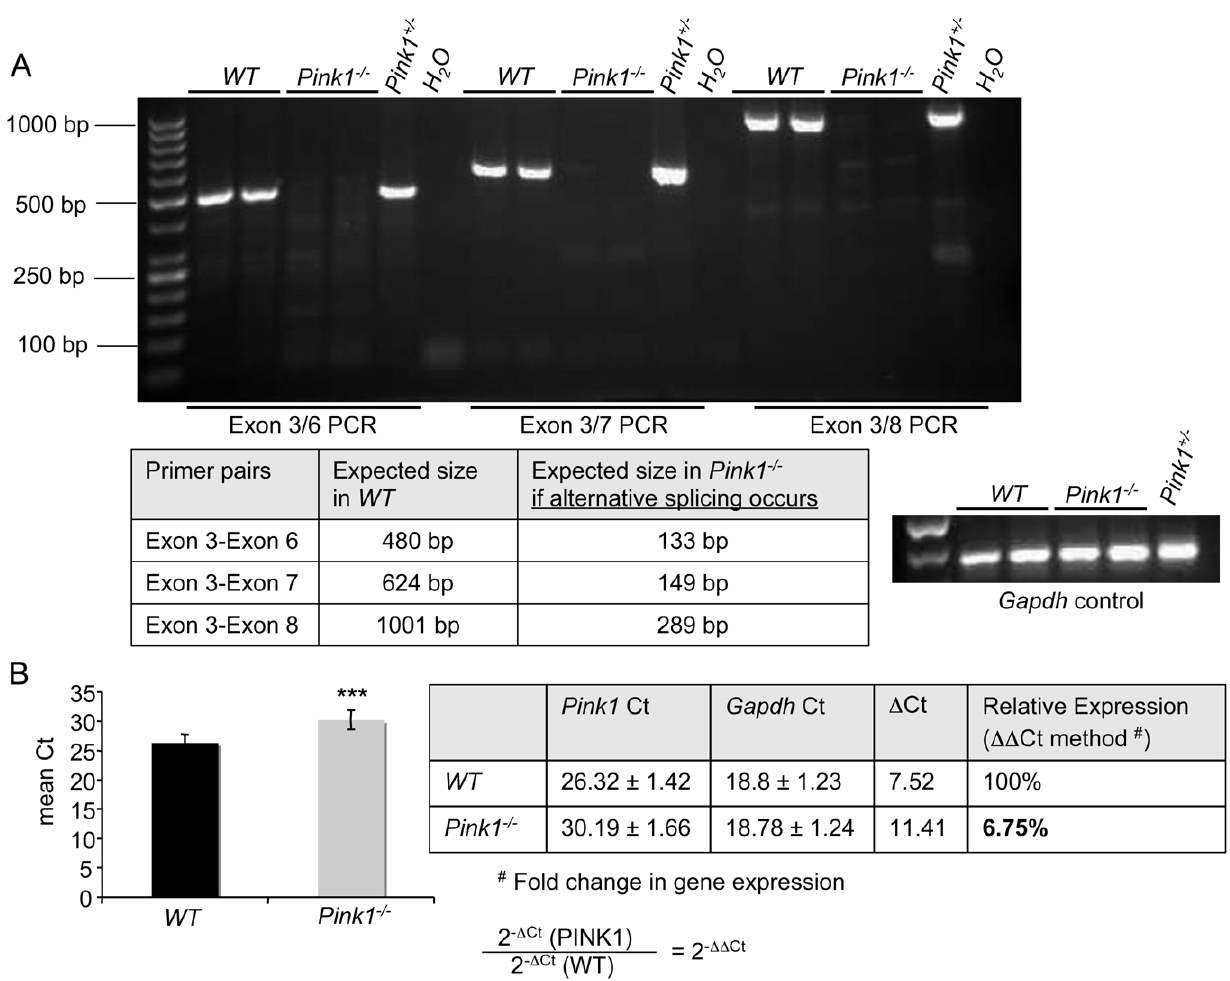
Figure 3. Analysis and quantification of Pink1 mRNA expression. Total RNA isolated from the brain of mice was converted to cDNA. (A) PCR with a forward primer located in exon 3 and reverse primers located in exon 6, 7 or 8, generating expected PCR products of 480, 624 and 1001 bp for the Pink1 wildtype allele in wildtype and Pink1 + / 2 samples. In contrast, PCR products of 133, 149 and 289 that would arise if exon 3 were directly spliced to exon 6, 7, or 8 in transcripts derived from the mutant Pink1 allele were absent in both Pink1 + / 2 and Pink1 2 / 2 samples. This shows that alternatively spliced transcripts are not generated from the disrupted Pink1 allele. (B) Quantitative real-time PCR with primers located in exon 1 (forward) and exon 3 (reverse) showing that Pink1 2 / 2 mice express at most 6.8% of a truncated Pink1 mRNA encompassing exons 1–3, compared to wildtype mice. However, such a truncated mRNA would not give rise to any PINK1 protein with kinase activity (see main text).